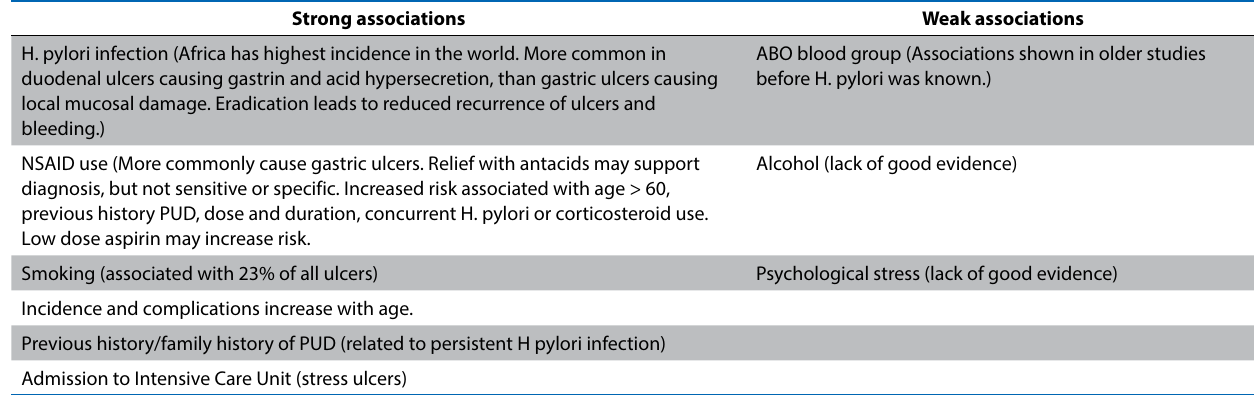
Table 4: Risk factors associated with PUD 43,45 Strong associations Weak